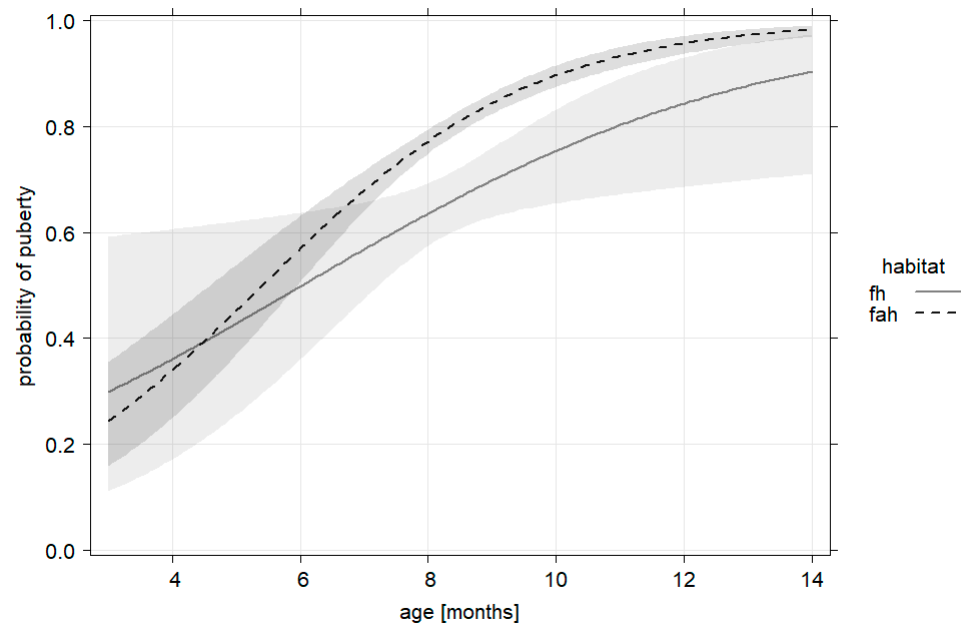
Figure 5. Different probabilities of puberty in the two landscape types (forest = fh, agriculture = fah), as described by age of piglets.